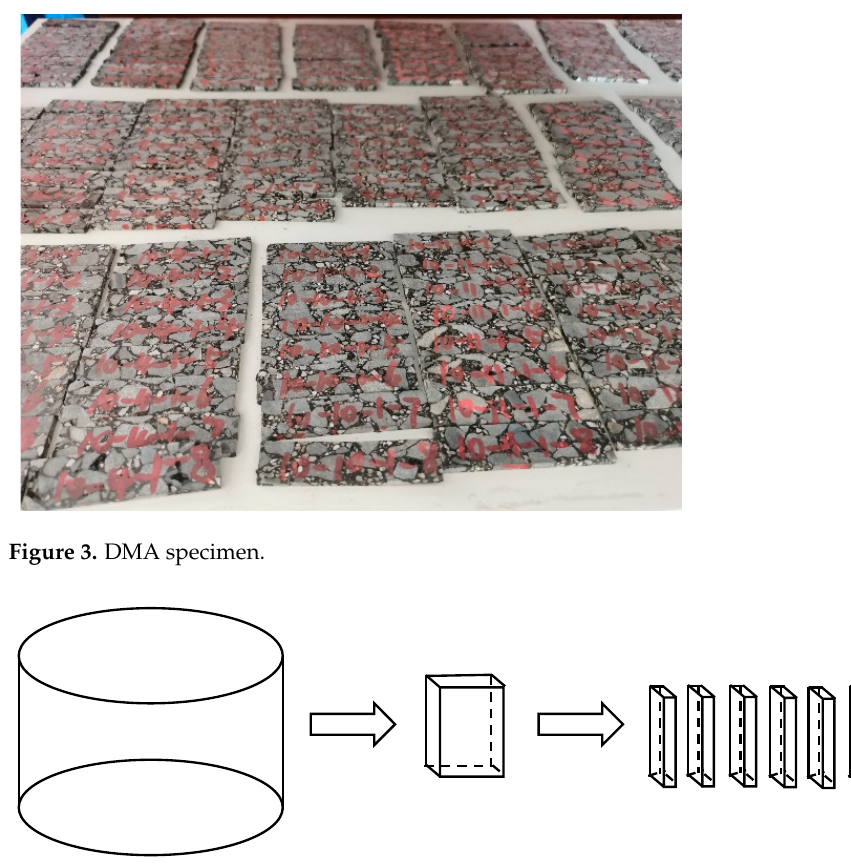
Figure 4. Diagram of specimen cutting.